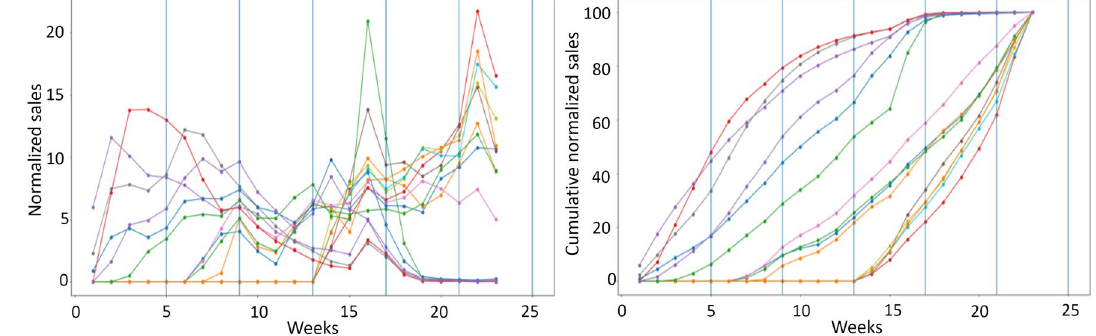
Fig. 6 Some examples of sales profiles in the case of normalized sales (left) and cumulative normalized sales